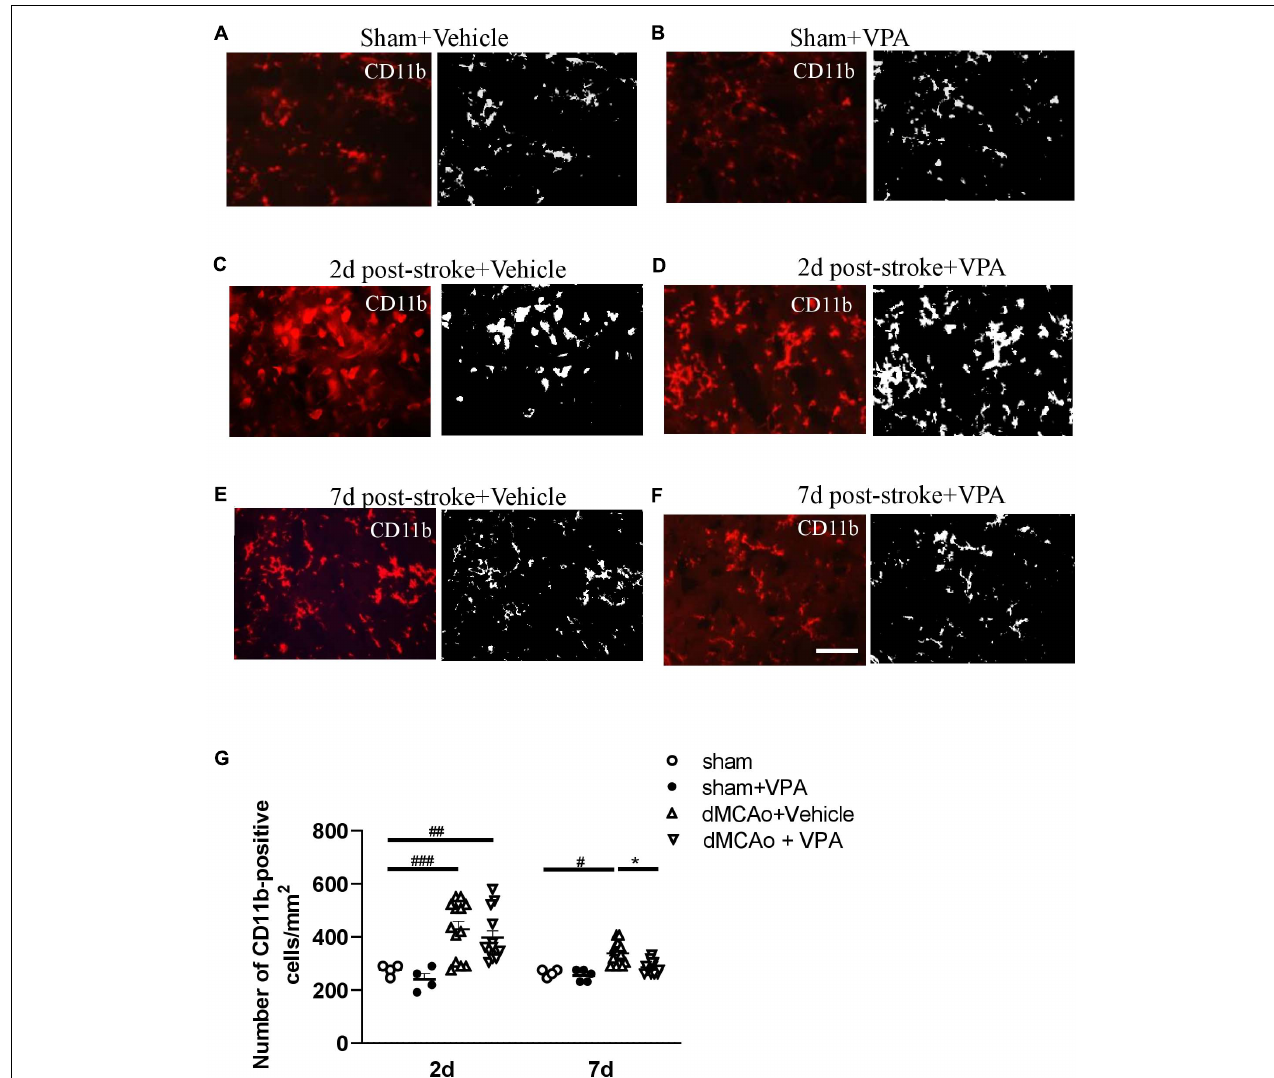
FIGURE 4 | Post-stroke intraperitoneal injection of VPA decreases the number of CD11b-positive cells in the peri-infarct cortex. (A–F) Representative photomicrographs of anti-CD11b immunofluorescent staining of the sham-operated cortex in vehicle-treated rats (A) , sham-operated cortex in VPA-treated rats (B) , peri-infarct cortex at 2 days after 90-min dMCAo in vehicle-treated rats (C) , peri-infarct cortex at 2 days after 90-min dMCAo in VPA-treated rats (D) , peri-infarct cortex at 7 days after 90-min dMCAo in vehicle-treated rats (E) , and peri-infarct cortex at 7 days after 90-min dMCAo in VPA-treated rats (F) . (G) Quantitation of CD11b-positive cells in the peri-infarct cortex at different time points showing accumulation of activated microglia/macrophages in the peri-infarct cortex at 2 and 7 days after ischemia. Original photomicrographs were subjected to a series of uniform Image J plugin protocols prior to conversion to binary images; binary images were then analyzed to calculate the number of CD11b-positive cells. # p < 0.05, ## p < 0.01, and ### p < 0.001 indicate statistical difference between peri-infarct cortex and sham-operated cortex at each time point, Bonferroni’s multiple comparisons test, following one-way ANOVA. * p < 0.05 indicates comparison with the dMCAo + vehicle group with two-way ANOVA, Bonferroni’s post hoc test. Five tissue sections per rat were used for the analysis ( n = 8–10). Scale bar: 20 µ m. The data represent mean ±